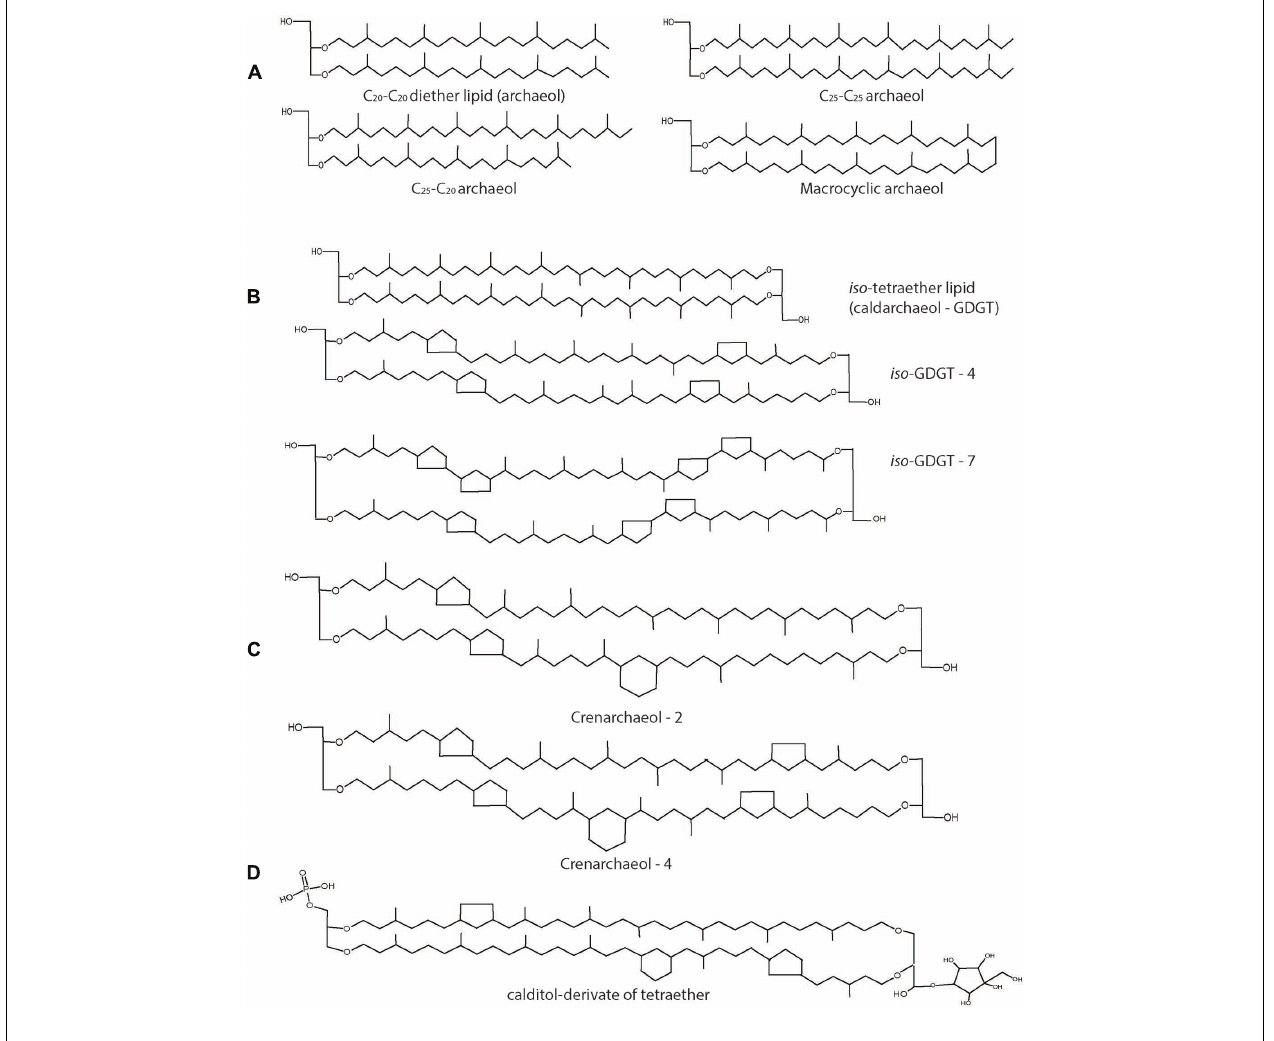
FIGURE 5 | Structures of archaeal lipids. (A) Diether lipids (archaeol) with modifications in chain length and with macrocyclic ring structure are mostly found in Euryarchaeota. (B) Tetraether lipids (caldarchaeol) can contain up to 8